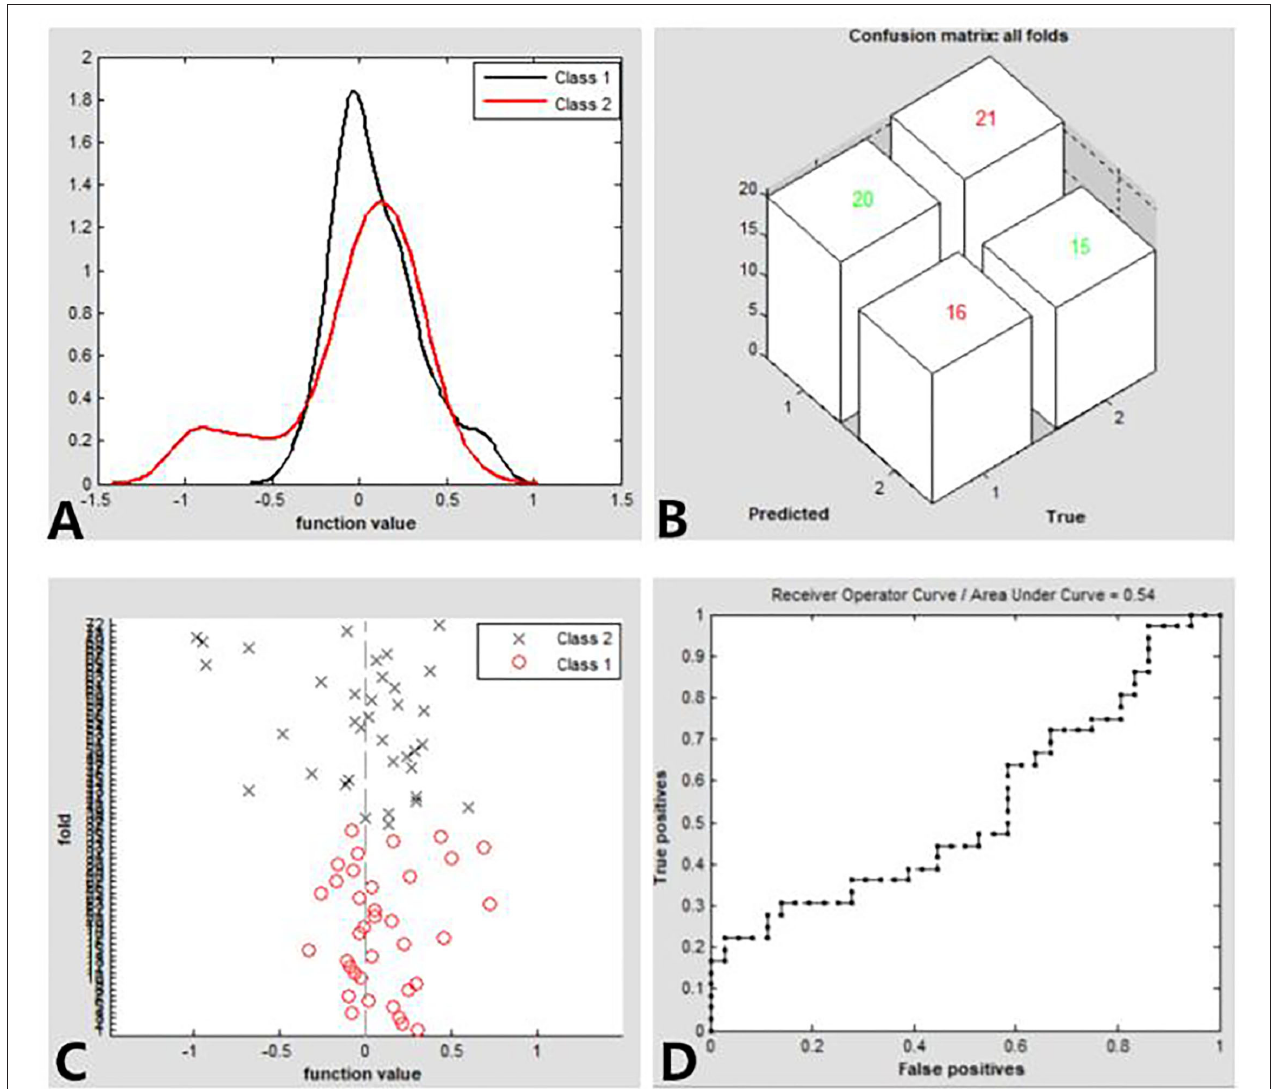
FIGURE 4 | Classification results using SVM based on dALFF values. Function values of two groups (class 1: CE group; class 2: HC group) (A) . three-dimensional confusion matrices (B) . a 10-fold in the class1 and class2 (C) . The ROC curve of the SVM classifier with an AUC value of.54 (D) . CE, comitant exotropia; HC, health control; dALFF, the dynamic amplitude of low-frequency fluctuation; ROC, receiver operating characteristic; SVM, support vector machine; AUC: area under the